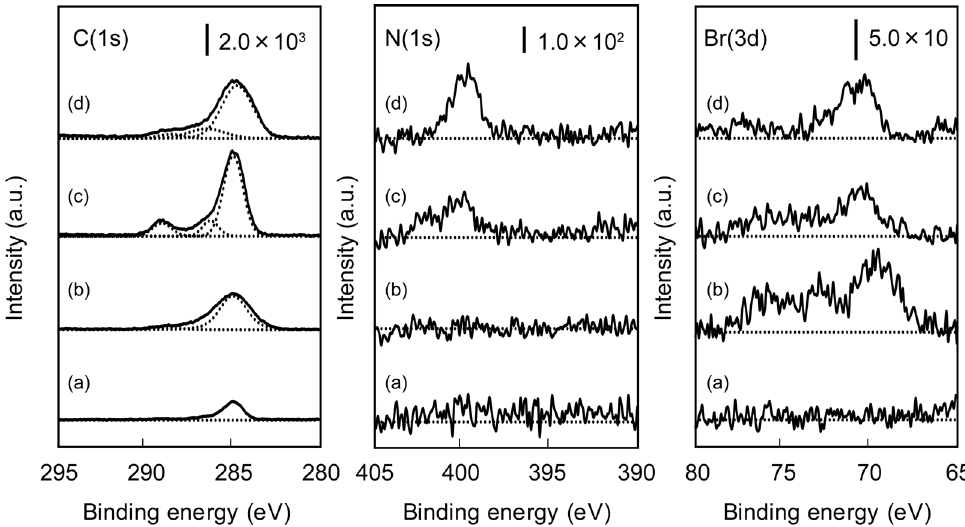
2. X-ray photoelectron spectroscopy (XPS) spectra of ( a ) unmodified; ( b ) TMSMA-immobilized; ( c ) poly(acetylated Man- t BMA)-immobilized; and